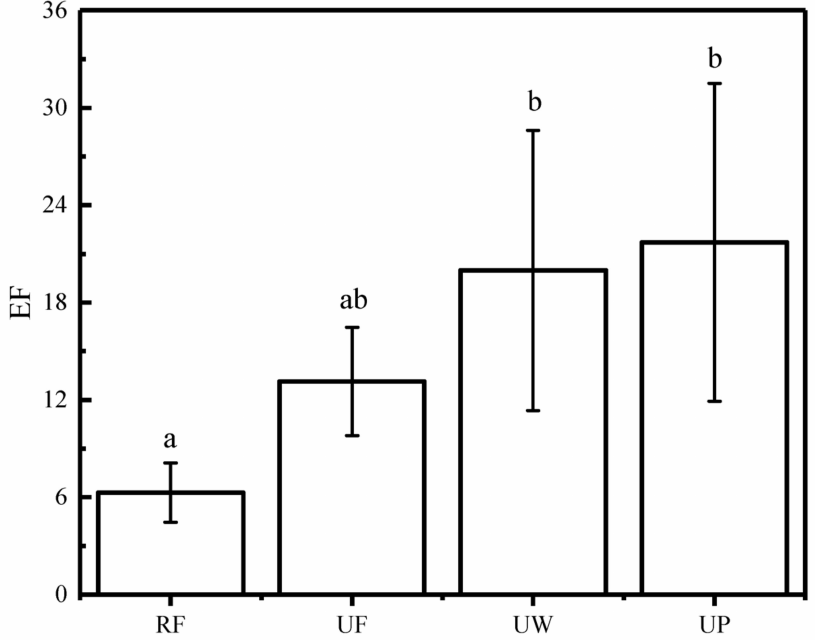
Figure 5. Enrichment factor (EF) of black carbon (BC) in soils. EF values are calculated from the BC content in soils divided by the background value of soils. RF = rural forest, UF = urban forest, UW = urban woodland, and UP = urban park. Different letters indicate significant differences among different interference intensities at the level of α =